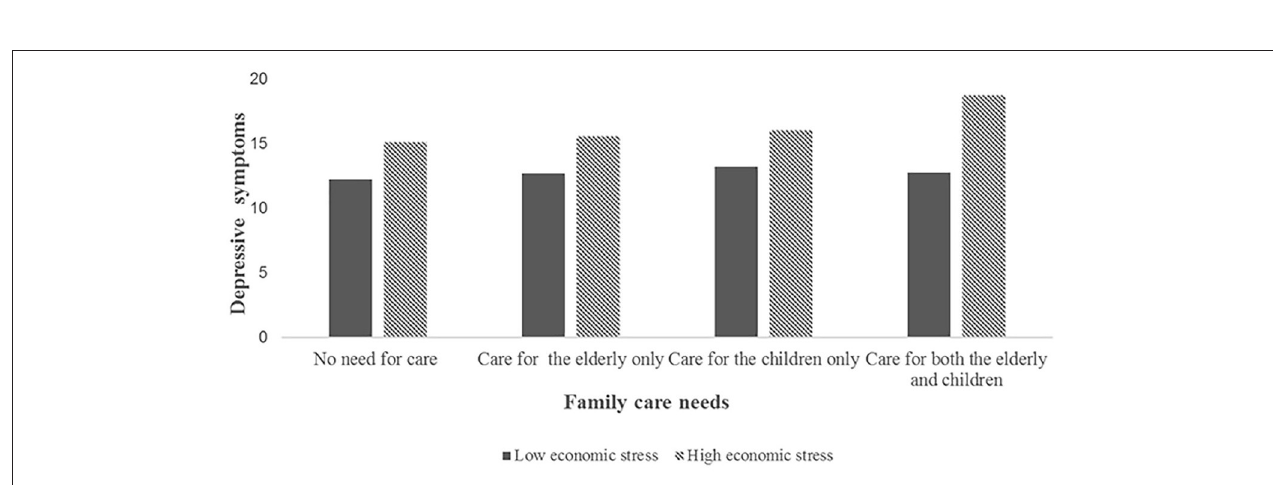
Frontiers in Psychiatry |